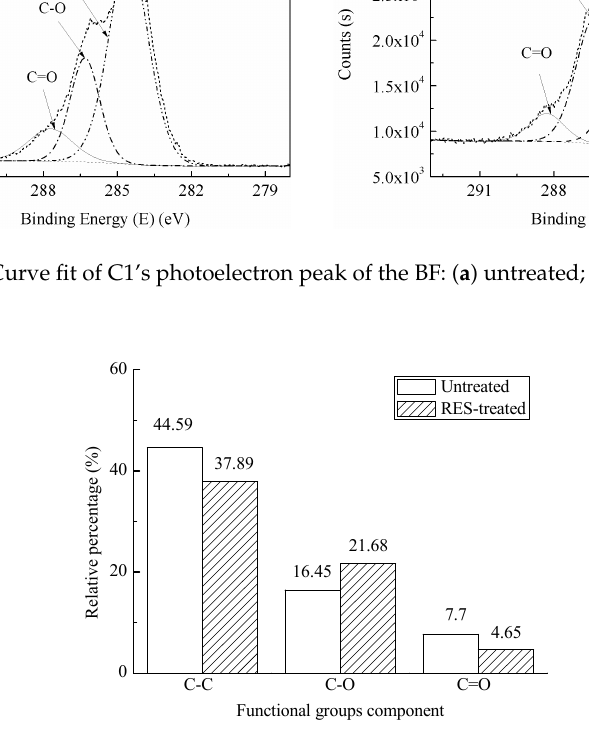
Figure 12. Relative percentage of the groups from the C1s peak curve fitting of BF.